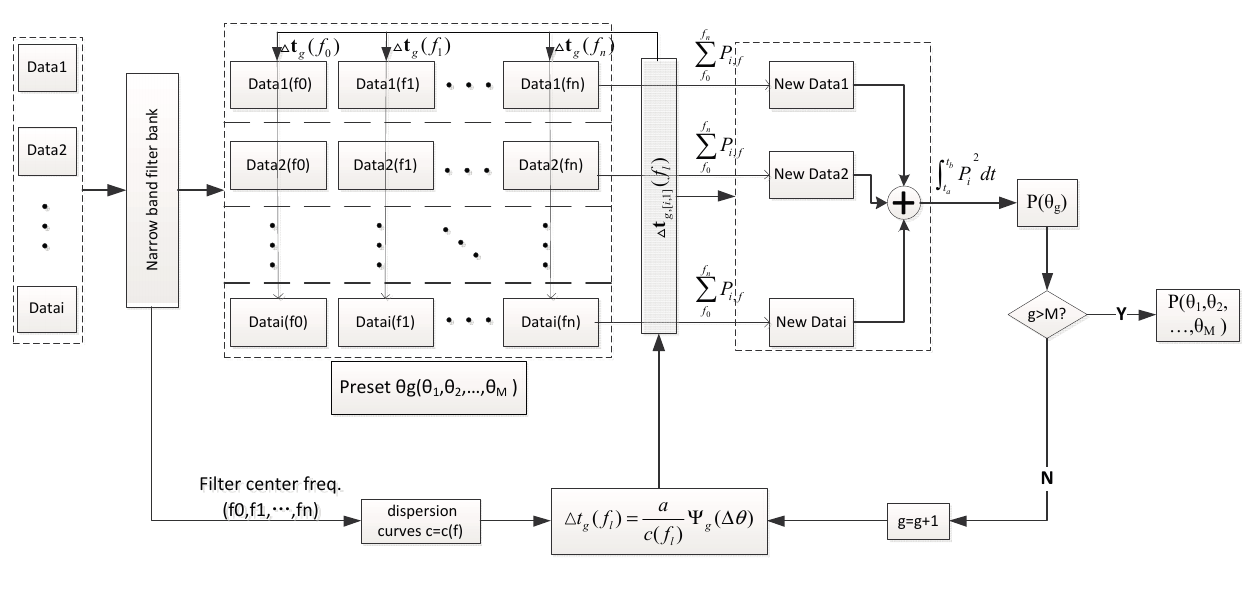
Figure 4. Up-to-date algorithm flow